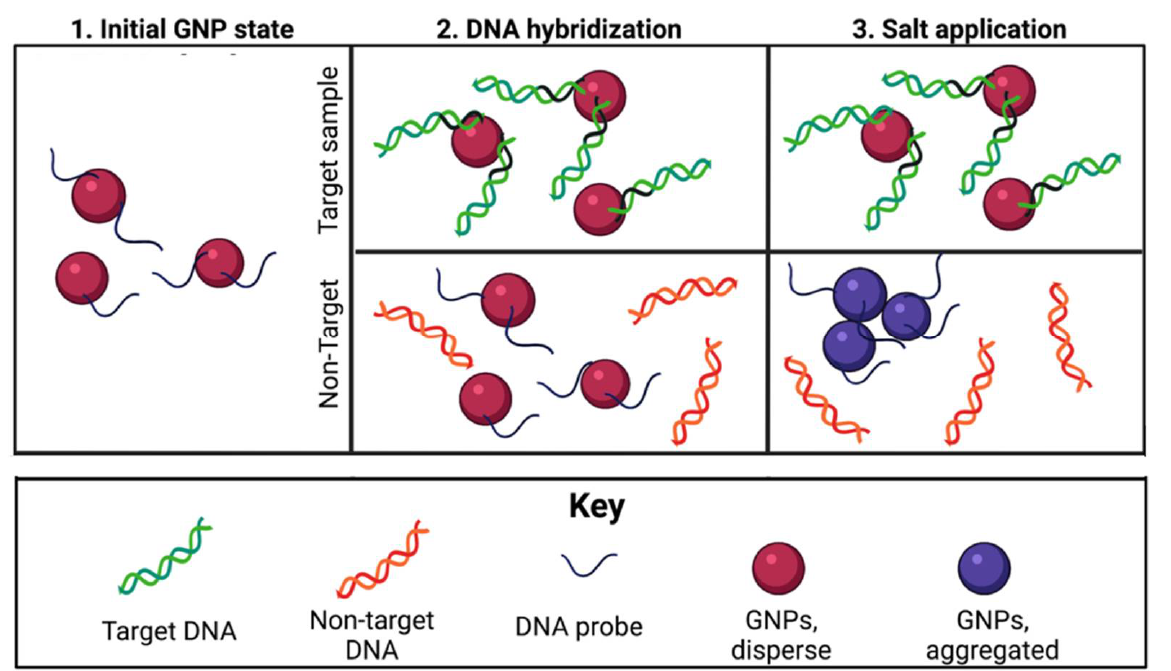
Figure 1. General mechanism for target-aggregating GNP colorimetric DNA biosensors.